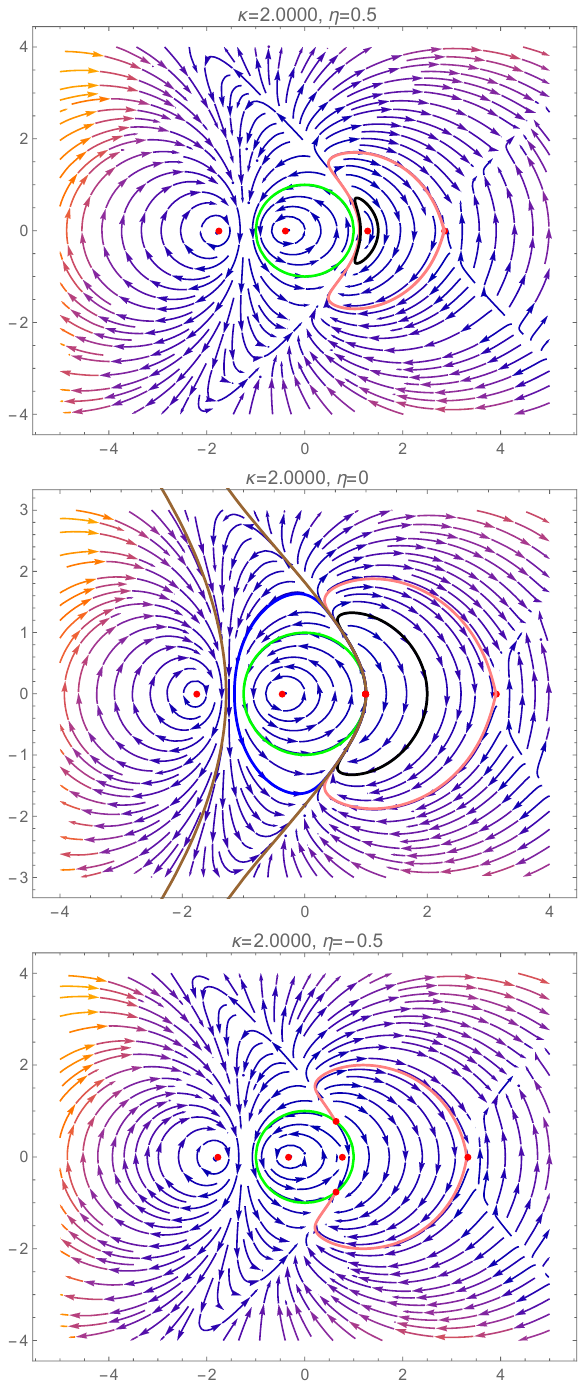
Figure 4. Phase portraits of system (7) and (8) inside and outside of the unit circle (green curve), for κ = 2. Several homoclinic and heteroclinic orbits are presented (the black, blue, brown and pink curves). A detailed description is given in Section